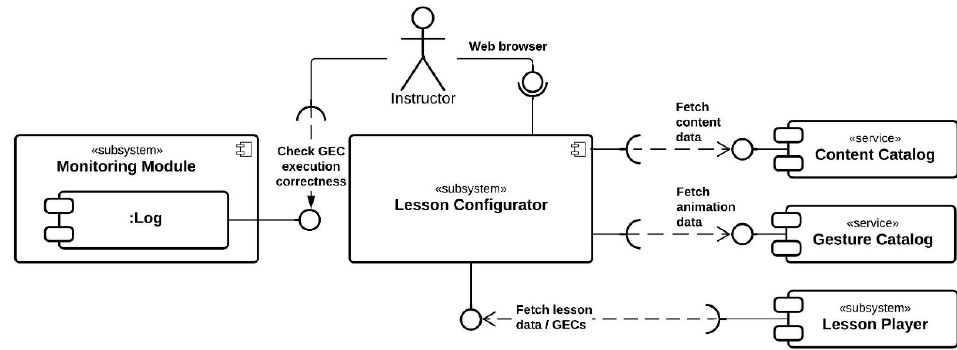
Figure 3. UML component diagram from the perspective of the instructor.